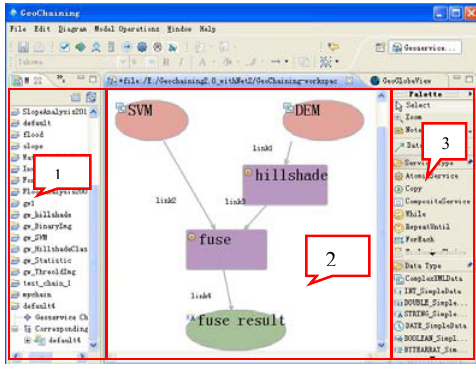
Figure 3. GUI of Visual Model Designer with demo model